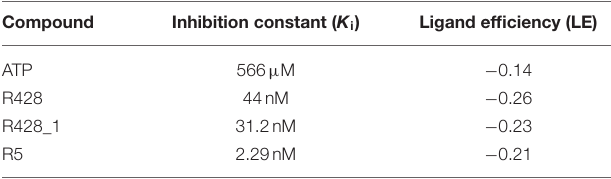
TABLE 7 | The inhibition constant and the ligand efficiency as calculated by the AutoDock software for the ATP, R428, best existing R428 analog—compound R428_1, and best designed compound R5—R428_1 derivative.